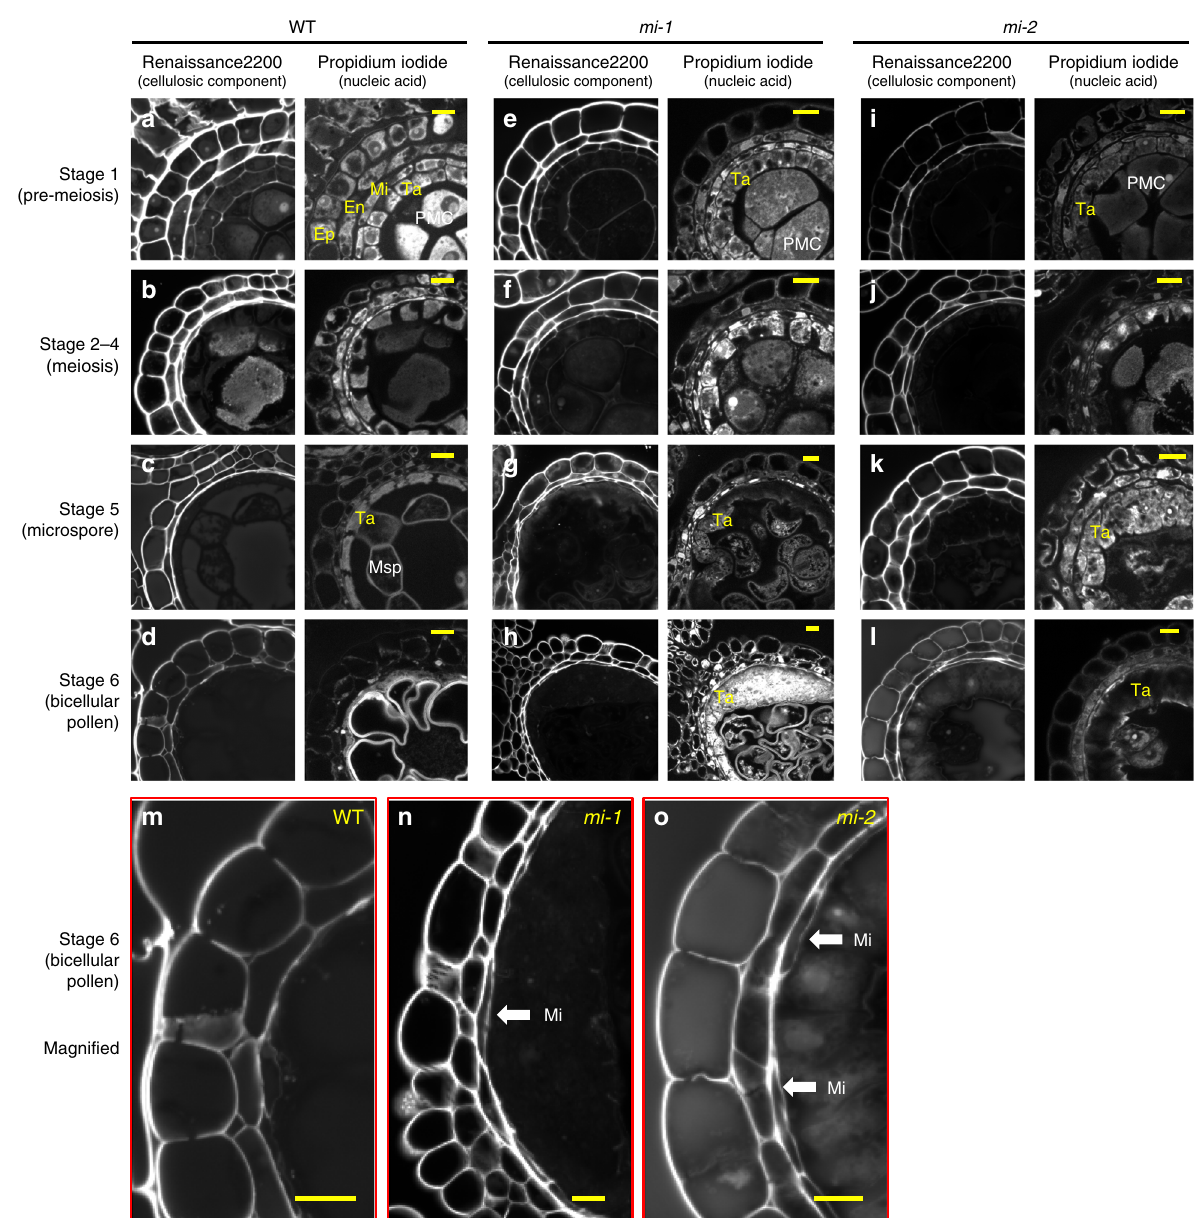
Fig. 3 miR2118 is involved in the maturation of the anther wall during post meiosis. a – l Cross-section images of anthers of WT ( a – d ), mi-1 ( e – h ), and mi- 2 ( i – l ). Panels depict anthers that were stained with Renaissance 2200 (left) and propidium iodide (right). Stage 1 is pre-meiosis, or primordial germ-cell initiation ( a , e , and i ); Stages 2 – 4 are during meiosis ( b , f , and j ); Stage 5 is the microspore development stage ( c , g , and k ); and Stage 6 is the bicellular pollen stage ( d , h , and l ). Tapetum defects were observed in mi-1 and mi-2 at Stages 5 and 6 after meiosis ( g , h , k , and l ). m – o Enlarged images of the anther wall that was stained with Renaissance 2200 of d , h , and l . Middle layers were retained at later stages, even at Stage 6, in both mi-1 and mi-2 compared to the Mi-collapse in the WT anther wall at Stage 5. Ep: Epidermis, En: endothecium, Mi: middle layer, Ta: tapetum, PMC: pollen mother cell, Msp: microspore. The white arrows indicate Mi. Yellow bars represent 10 μ